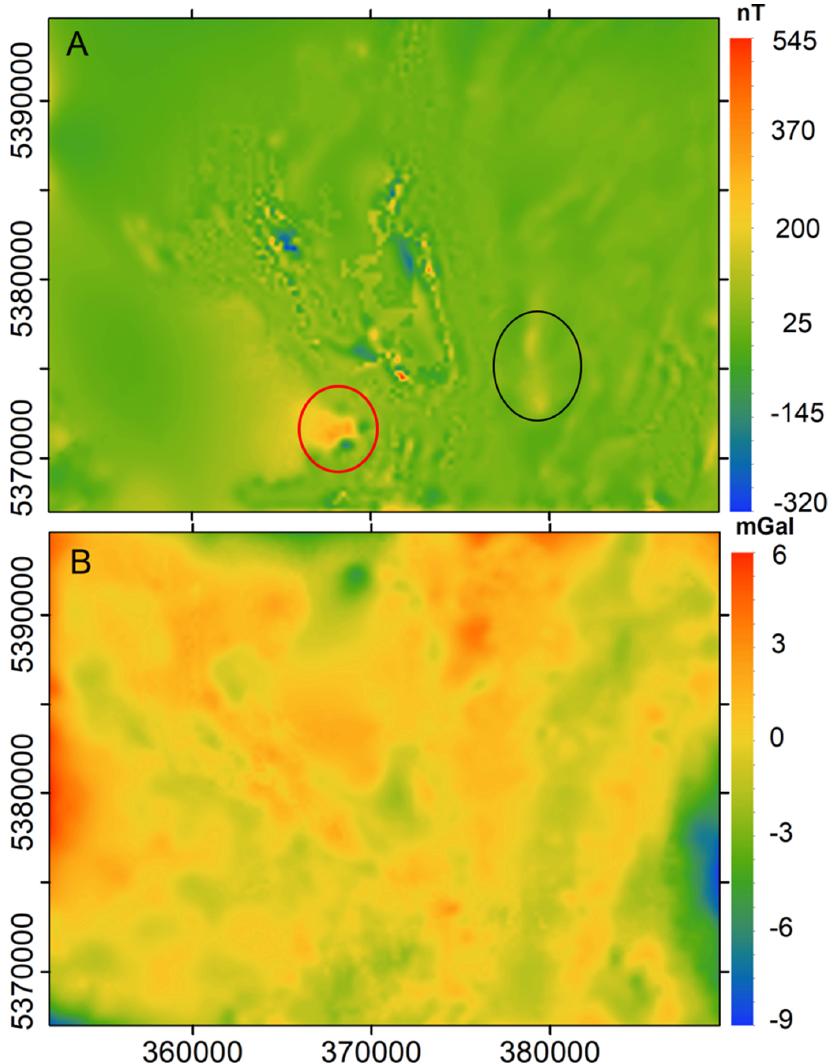
Figure 16. ( A ) The TMI residual misfit of the Rosebery–Pieman 3D model after cooperative inversion (rms misfit 41.47 nT). Ultramafic complexes were modeled as 3 distinct units due to their substantial compositional variation. Red ellipse represents positive residuals proximal to the Renison Bell deposit while the black ellipse is associated with magnetic material within the Central Volcanic Sequence. ( B ) The gravity residual misfit. The rms misfit is 1.56 mGal. The magnetic inversion took longer to converge (approximately 1 billion iterations),